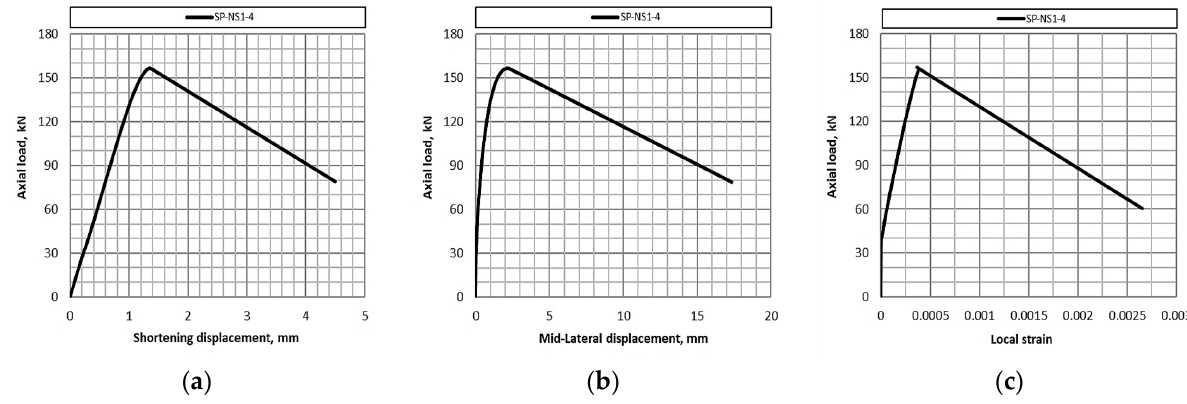
Figure 3. Axial load-shortening displacement ( a ) mid-lateral displacement ( b ) and local strain ( c ) for intact stiffened plate SP-NS1-4.